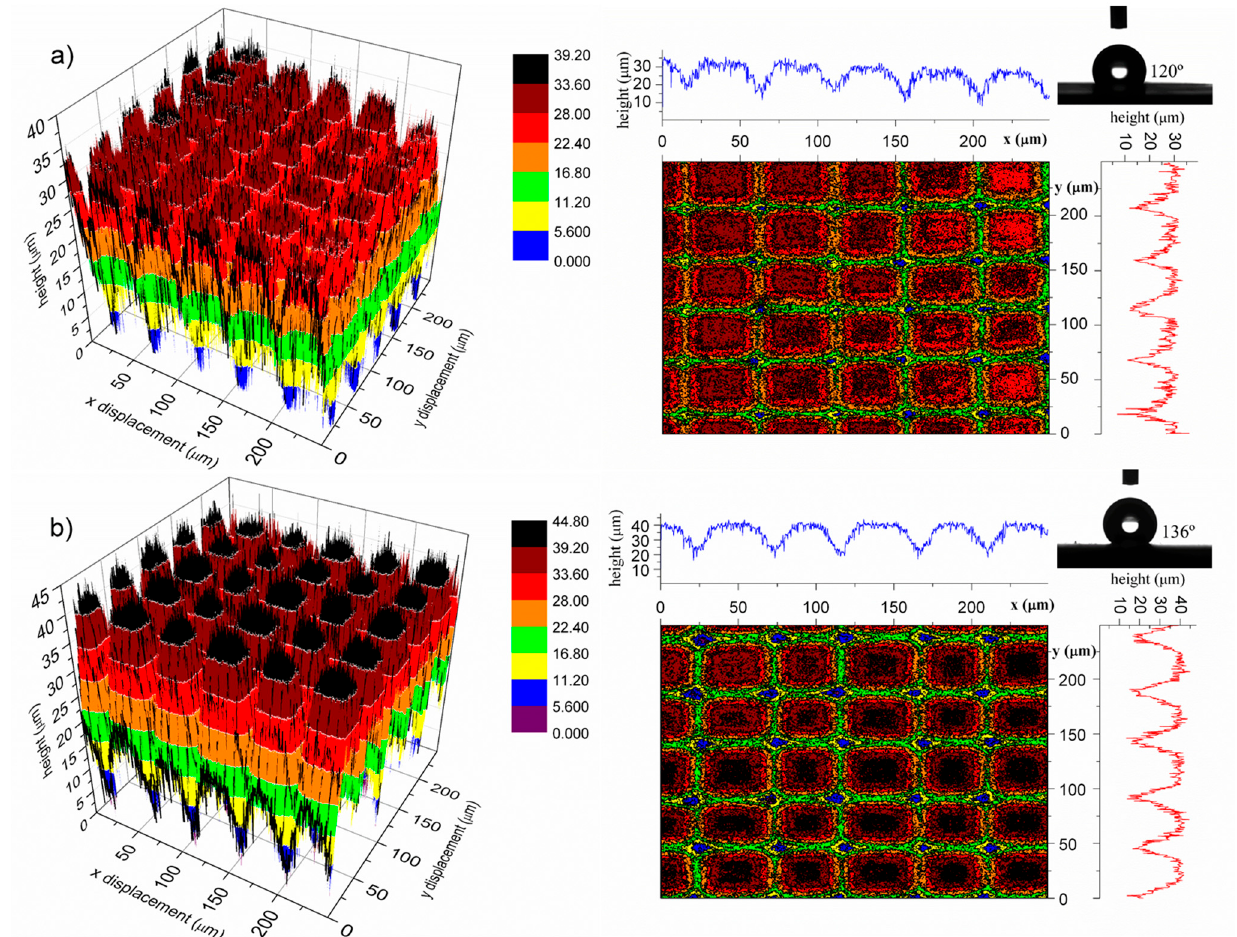
Figure 10. Surface topography and contact angle during the second shape memory cycle: ( a ) deformed (temporal shape) and ( b ) recovered